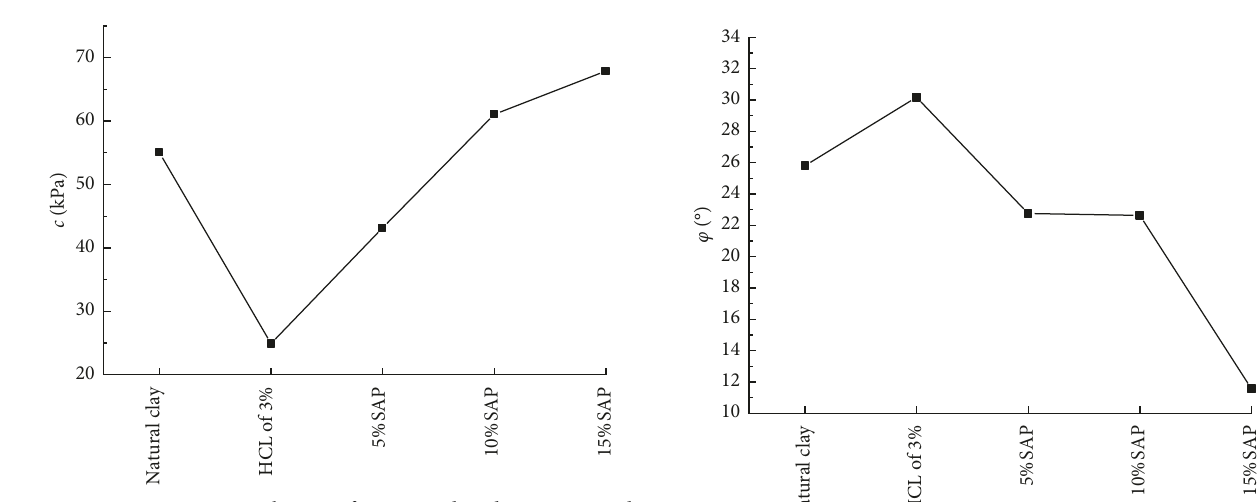
Figure 16: Variation in cohesion of SAP-cured acid-contaminated clay. Figure